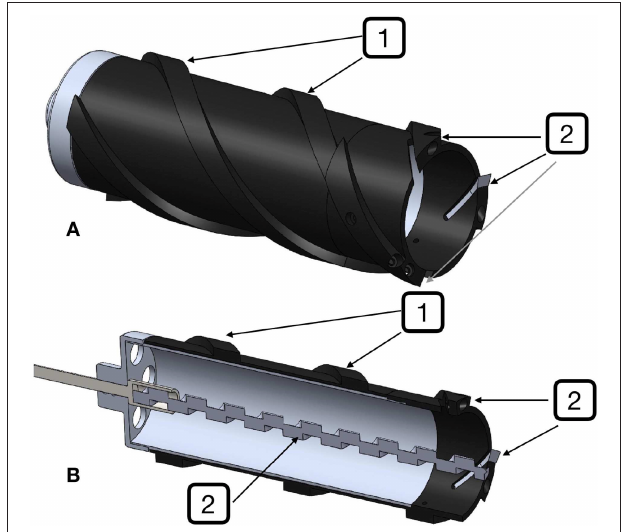
FIGURE 2 | (A) A rendering of the final drill design. (B) A cutaway that shows the aluminum cylinder and the center drill. The following components are labeled: 1. The spiral sleeve; 2. cutting teeth; center drill.